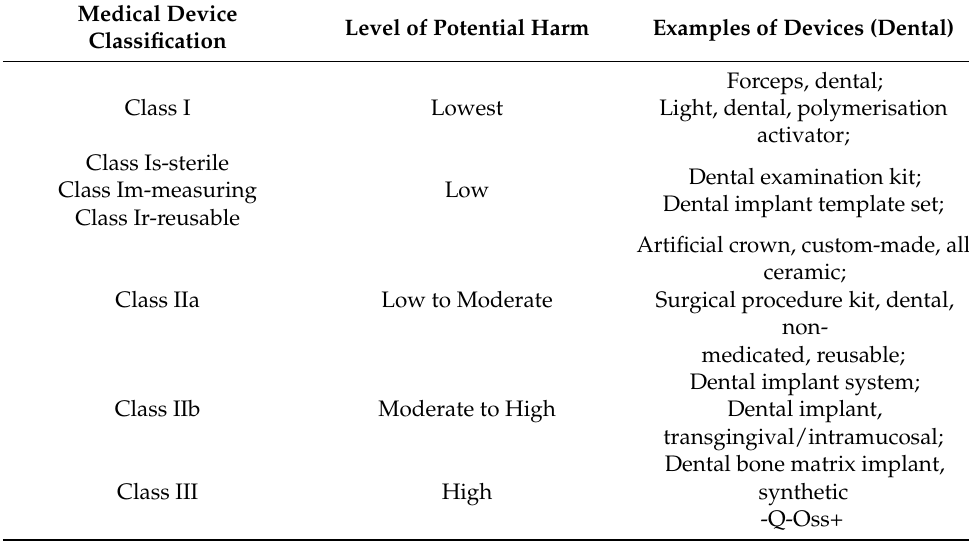
Table 1. Classification of medical devices based on their regulatory requirements based on The European Union Medical Device Regulation and Australia’s Therapeutic Goods